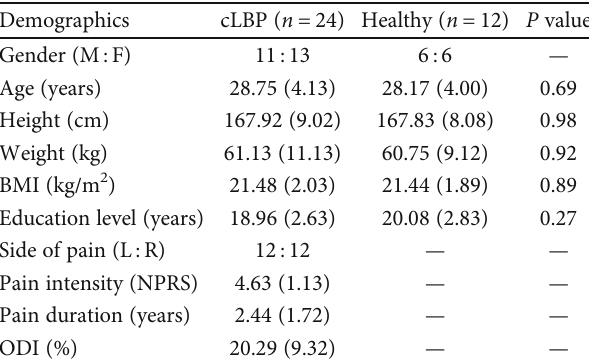
Table 1: Characteristics of the sample cohorts ( mean ± ð SD Þ ). Demographics